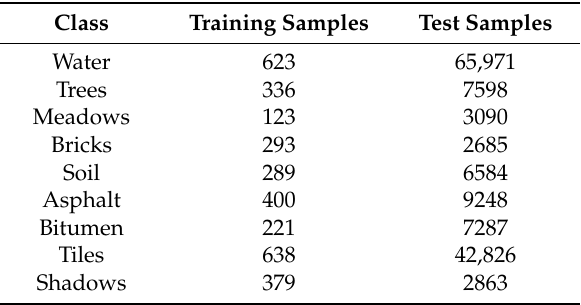
Table 2. Number of training samples and reference data for the Pavia Center